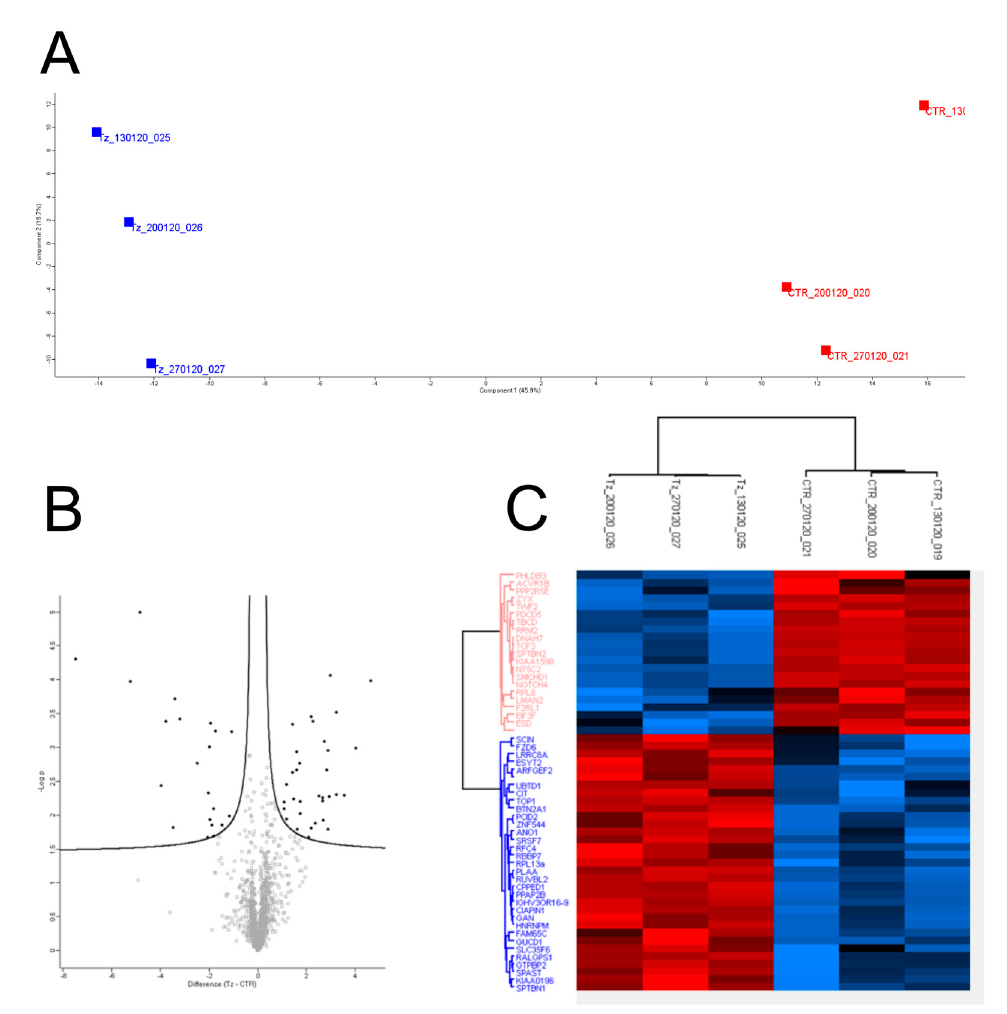
Figure 3. Principal component analysis, volcano plot and unsupervised hierarchical clustering analysis of proteins associated with EVs released from Tz treated or control SKBR-3 cells. ( A ) Two-dimensional scatter plot of the principal component analysis of EVs released from Tz treated (blue dots) or control IgGs treated SKBR-3 cells (red dots). ( B ) Volcano plot representation of differentially expressed proteins. ( C ) Unsupervised hierarchical-clustered heatmap of 52 proteins identified by Multiple-samples test ANOVA performed on the EVs purified from the SKBR-3 cell line. The amount of each protein in individual samples is represented by the color scheme in which red and blue indicate high and low expression of proteins, respectively. Three independent biological replicates of cells treated with Tz or IgGs (control, CTR) are shown. Proteins are clustered into two groups according to their expression value. In particular, 32 were up-regulated in EVs from Tz treated cells, while 21 were upregulated in EVs from control cells.